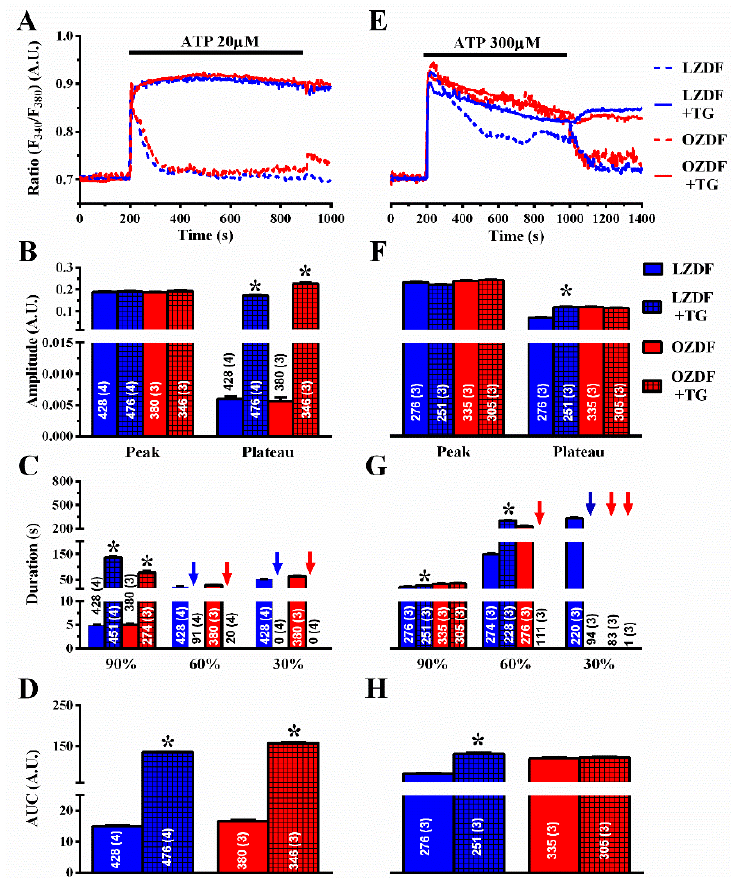
Figure 7. The e ff ect of thapsigargin on the Ca 2 + response to ATP is larger in native aortic endothelium of obese Zucker diabetic fatty rats. ( A ) Representative recordings of the Ca 2 + response to 20 µ M ATP in the absence or presence of 1 µ M thapsigargin (TG in the figure) in native aortic endothelium of LZDF and OZDF rats. In thapsigargin experiments, ATP and thapsigargin were applied at the same time. ( B ) Mean ± SE of endogenous Ca 2 + release and SOCE amplitude recorded in native aortic endothelium of LZDF and OZDF rats challenged with 20 µ M ATP in the absence or presence of 1 µ M thapsigargin. The asterisk indicates p < 0.05. ( C ) Mean ± SE of the duration of the Ca 2 + response to 20 µ M ATP recorded in native aortic endothelium LZDF and OZDF rats in the absence or presence of 1 µ M thapsigargin. The asterisk indicates p < 0.05. ( D ) Mean ± SE of the AUC of the Ca 2 + response to 20 µ M ATP recorded in native aortic endothelium of LZDF and OZDF rats in the absence or presence of 1 µ M thapsigargin. The asterisk indicates p < 0.05. ( E ) Representative recordings of the Ca 2 + response to 300 µ M ATP in the absence or presence of 1 µ M thapsigargin in native aortic endothelium of LZDF and OZDF rats. In thapsigargin experiments, ATP and thapsigargin were applied at the same time. ( F ) Mean ± SE of endogenous Ca 2 + release and SOCE amplitude recorded in native aortic endothelium of LZDF and OZDF rats challenged with 300 µ M ATP in the absence or presence of 1 µ M thapsigargin. The asterisk indicates p < 0.05. ( G ) Mean ± SE of the duration of the Ca 2 + response to 300 µ M ATP in native aortic endothelium of LZDF and OZDF rats in the absence or presence of 1 µ M thapsigargin. Blue and red arrows indicate that the Ca 2 + signal failed to reach the clearing rate indicated in the graph in LZDF and OZDF rats respectively. The asterisk indicates p < 0.05. ( H ) Mean ± SE of the AUC of the Ca 2 + response to 300 µ M ATP in native aortic endothelium of LZDF and OZDF rats in the absence or presence of 1 µ M thapsigargin. The asterisk indicates p < 0.05, Mann-Whitney test. 2.5. PMCA Activity Is Not Altered in Native Aortic Endothelium of OZDF Rats Next, we evaluated whether PMCA activity was impaired in native aortic endothelium of OZDF rats. To address this issue, the Ca 2+ response to 20 µM and 300 µM ATP was measured in the absence